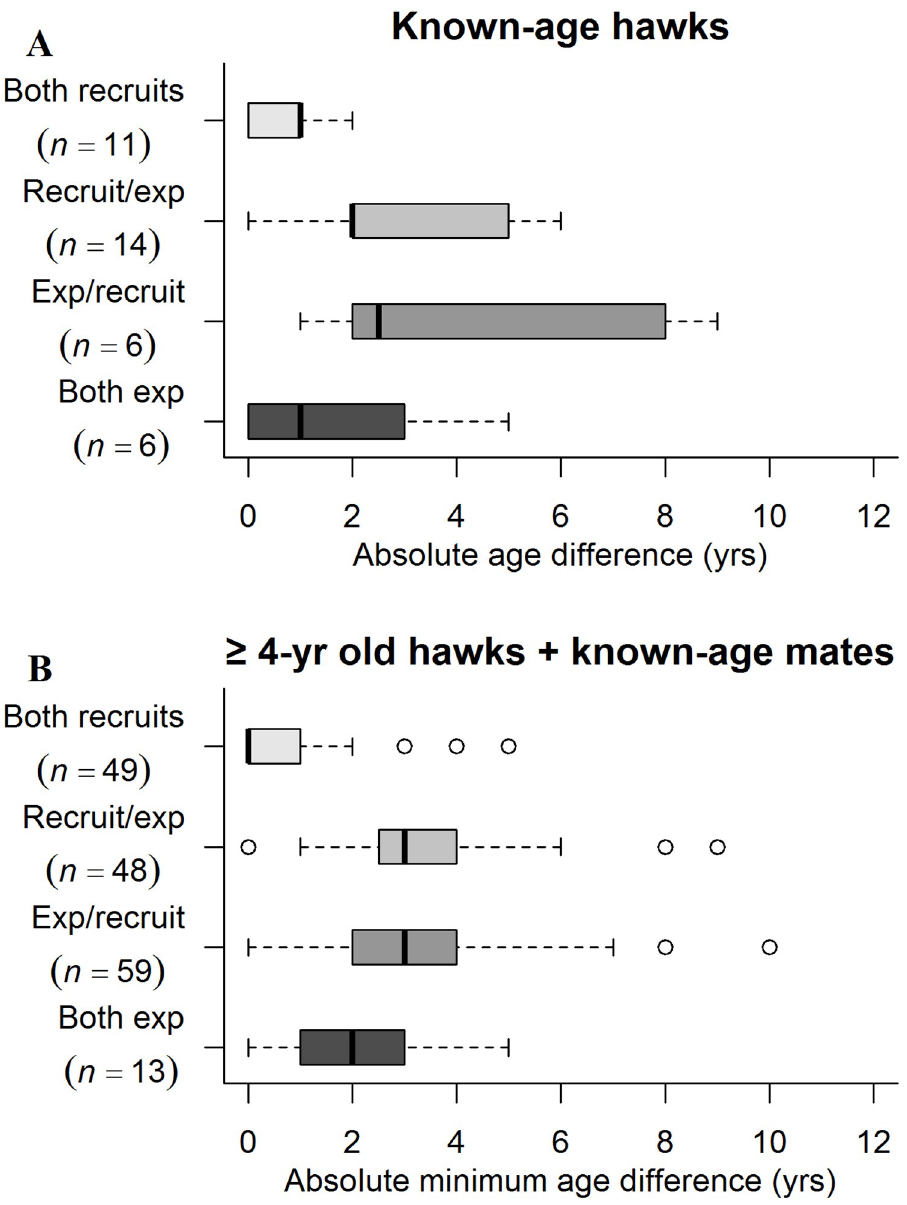
Fig 9. Is mate choice based on a mate’s breeding experience? Box plots of pair age differences in the year of pair formation with respect to a mate’s breeding experience by northern goshawks in Arizona, USA. Vertical bars are medians (i.e., 50 th percentile), boxes contain the central 50% of differences (i.e., bounded by the 25 th and 75 th percentiles), and dots are outliers. “Both recruits” pairs are both first-time breeders, “recruit/exp” pairs are male recruit/female experienced, “exp/recruit” pairs are male experienced/female recruit, and “both exp” pairs are both previous breeders. (A) Known-age hawks only and (B) hawks aged � 4-years-old with their known-age mates where